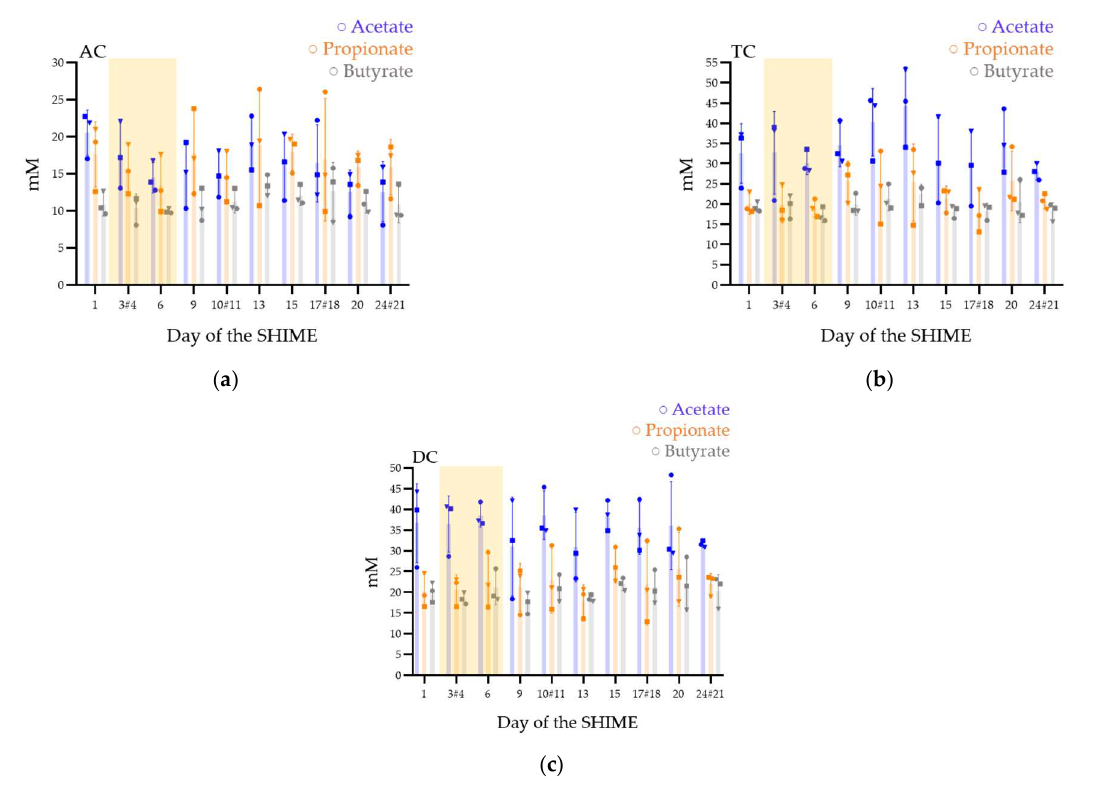
Figure 4. Short-chain fatty acid production (acetate, propionate, and butyrate) in the ascending (AC) ( a ), transverse (TC) ( b ), and descending (DC) ( c ) colons in the SHIME ® model after one daily ULIP33 phage injection (10 mL at 10 9 PFU/mL) in the ascending colon for 7 days. Mean concentrations (±SD) are presented in mM for acetate (blue bars), propionate (orange bars), and butyrate (gray bars); all are quantified using SPME-GC-MS, 3 times a week. Round marks: data of the repetition 1; square marks: data of the repetition 2; triangle marks: data of the repetition 3; yellow frame represents the phage treatment week and # are the samples with a different sample date in the different triplicates. Table 1. Average concentrations (in mM) of acetate, propionate, butyrate, total SCFA, and ac- etate/propionate/butyrate ratio observed in the ascending, transverse, and descending colons